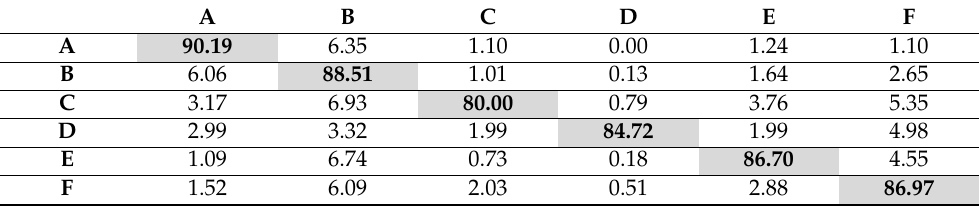
Table 6. Confusion matrix (%) of 2D-DIDGP on Set 2 using Random Forest classifier.